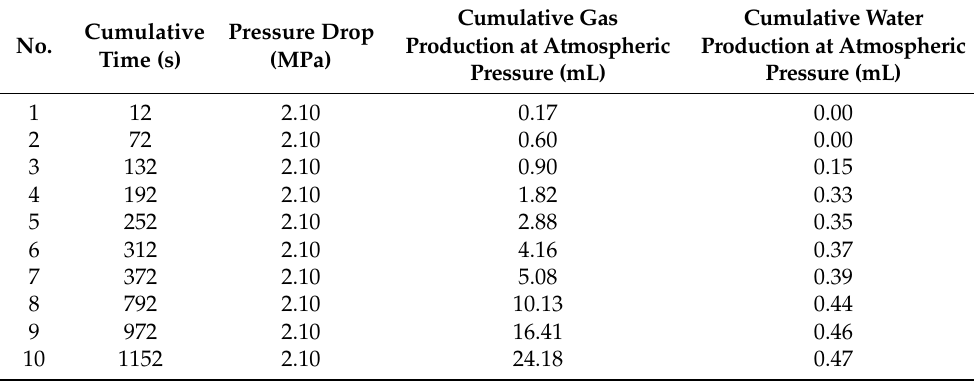
Table A3. The experimental results of No.3 (The mass of saturated water is 1.78